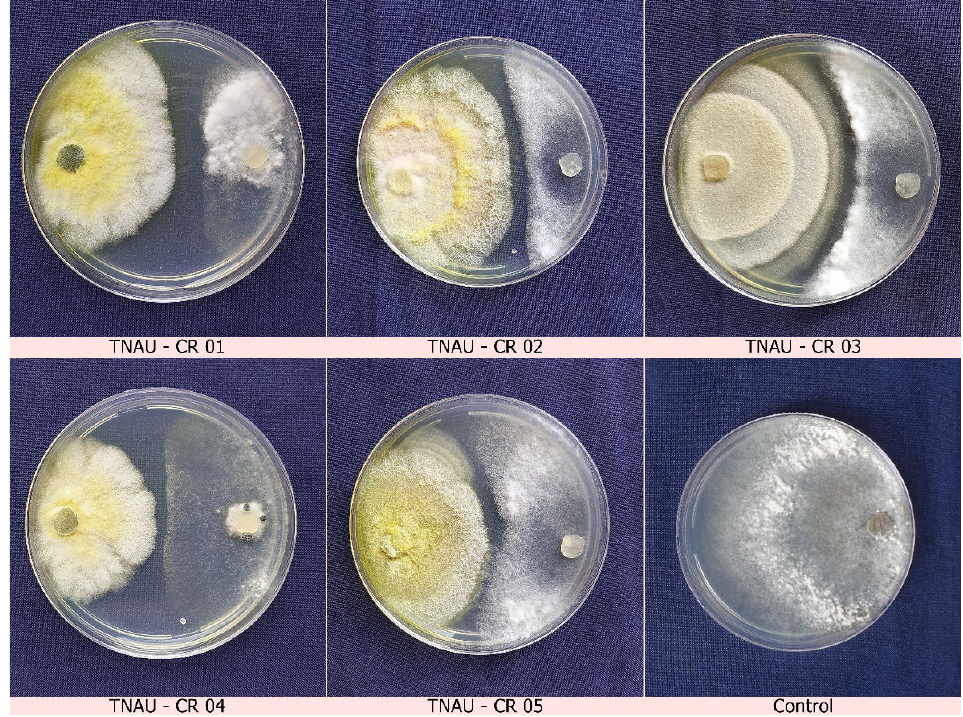
Figure 3. Dual culture assays of C. rosea against S . sclerotiorum twenty days after inoculation ( left side —biocontrol agent, C. rosea ; right side —pathogen, S . sclerotiorum ). Table 1. Dual culture assays of C. rosea against S . sclerotiorum twenty days after inoculation. Sl.No.